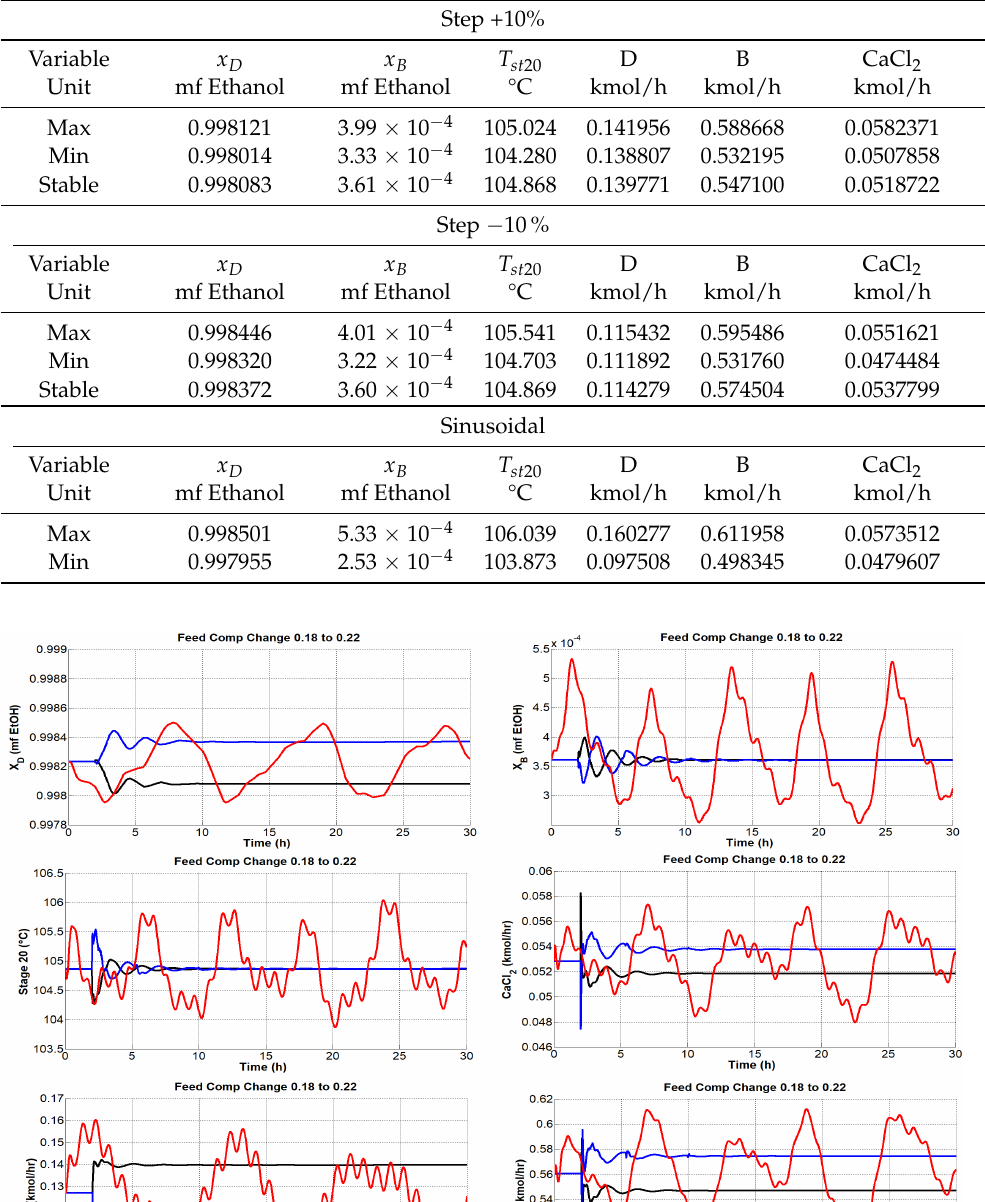
Table 7. The behavior of the process using the structure L. Maximum, minimum, and stabilization values in the event of disturbances in the feed composition.